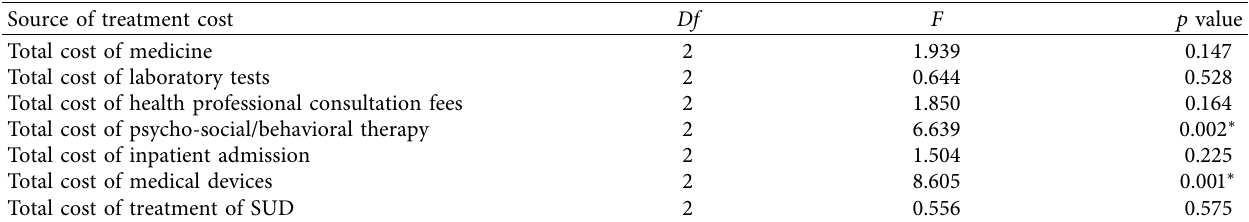
∗ Statistical significance ( p value <